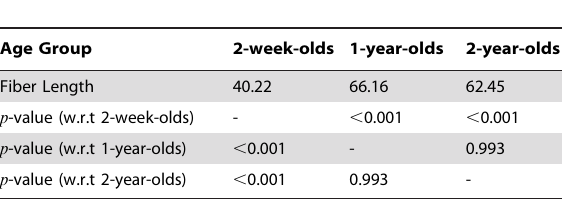
Table 2. Average Lengths of Connection Fibers